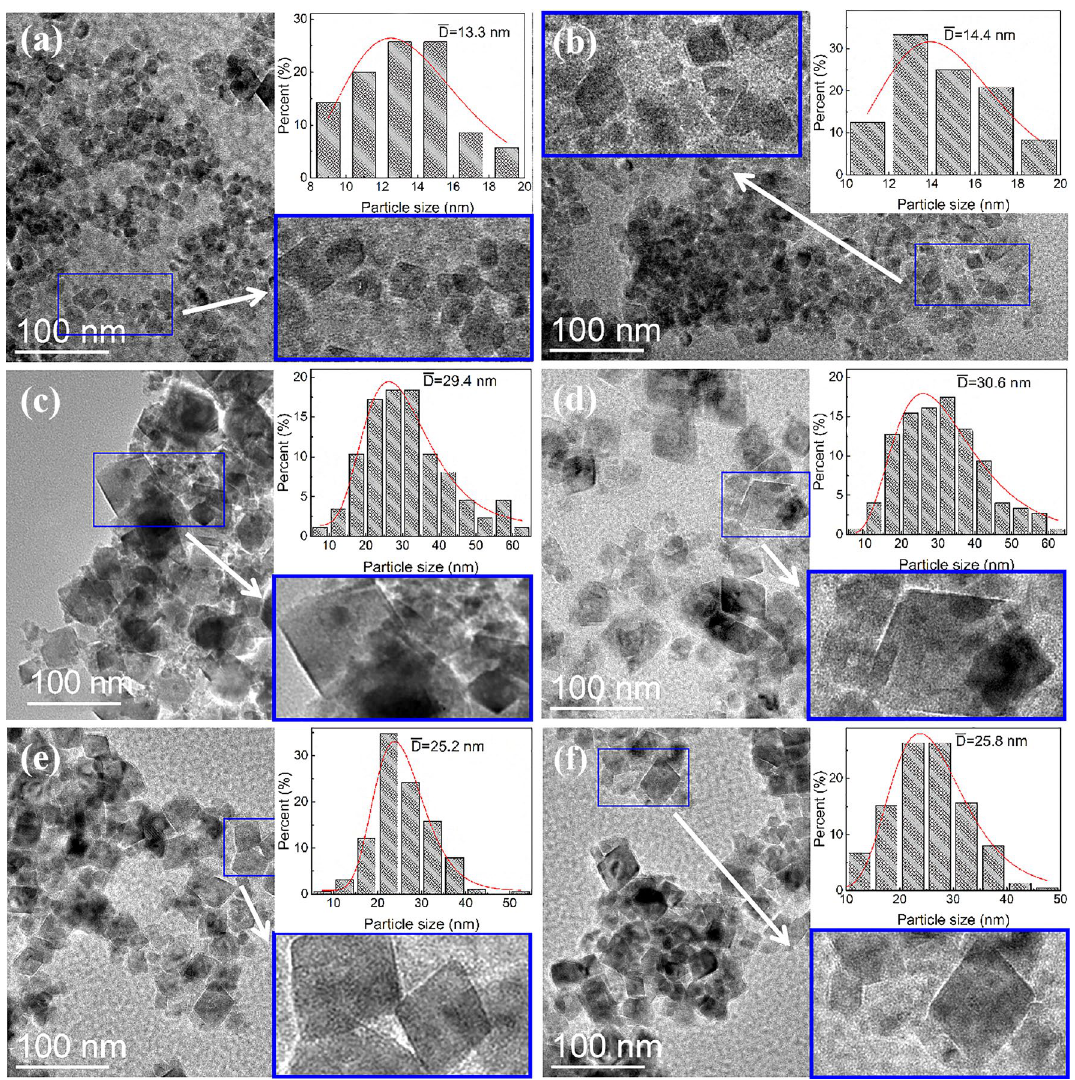
Figure 1. TEM images of MNPs and size distributions (the insets): ( a ) FO, ( b ) C/FO, ( c ) ZCF-3, ( d ) C/ZCF-3, ( e ) ZCF-2, ( f ) C/ZCF-2.